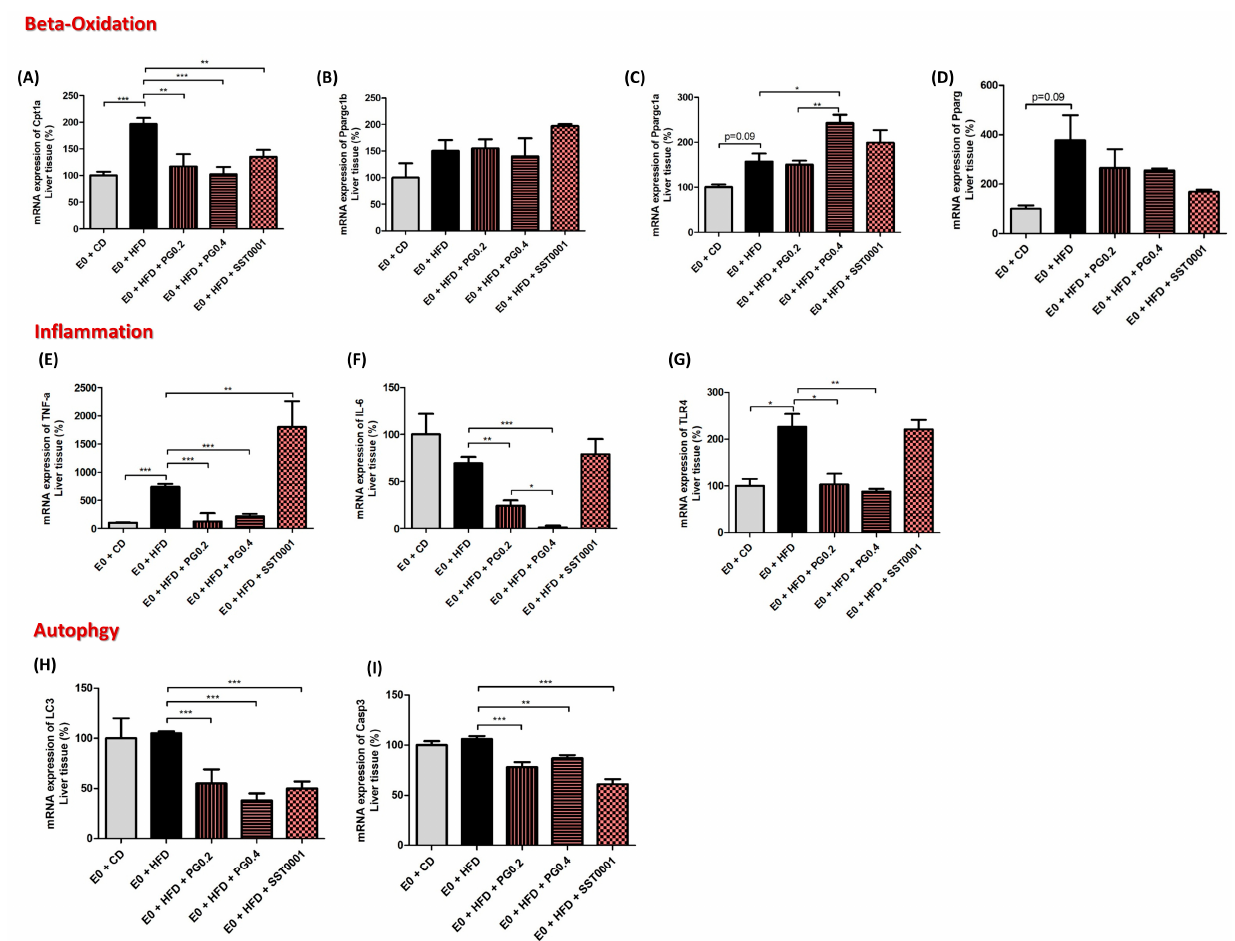
Figure 7. Effect of heparanase inhibition on lipid oxidation ( A – D ), inflammatory stress ( E – G ) and autophagy ( H , I ) in the liver. * p < 0.05, ** p < 0.01, *** p < 0.001. Effect of PG545 on oxidative stress. PG545 caused a significant dose-dependent reduc- tion in serum OS, evident by decreasing lipid peroxide (PD) content from 986 ± 16 nmol/mL in the E 0 control group to 871 ± 37 nmol/mL ( p = 0.02) and to 746 ± 22 nmol/mL ( p < 0.001) in the low and high dose treated groups, respectively, and by decreasing TBARS levels from 27 ± 1 nmol MDA/mL in the E 0 control group to 20 ± 2 nmol MDA/mL ( p = 0.01) and to 12 ± 0.6 nmol MDA/mL ( p < 0.001) in the low and high dose treated groups, respectively (Table